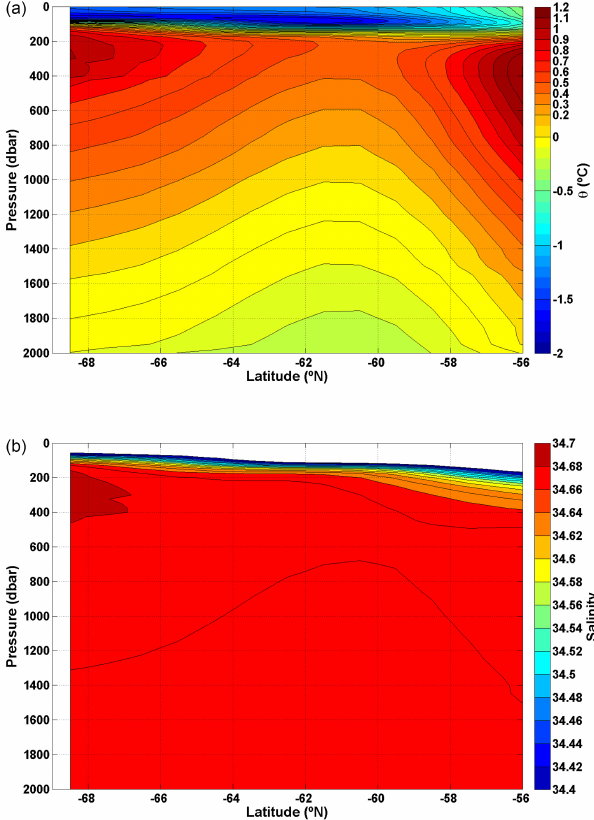
Figure 32. Potential temperature ( ◦ C) (a) and salinity (b) for a sec- tion from 56 ◦ S to the coast along the Prime Meridian from the WOA13 climatology; time span 2005 to